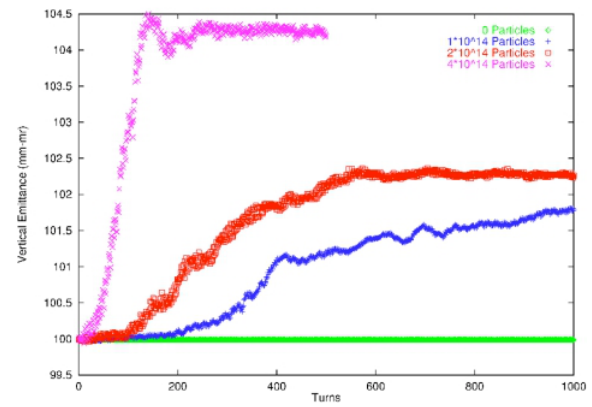
FIG. 6. (Color) Vertical emittance evolution for four beam intensities. Increased beam intensity yields increased emittance growth due to halo formation.